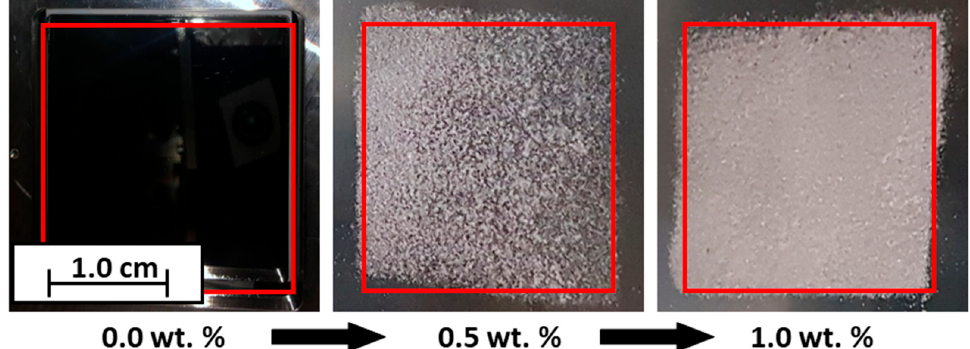
Figure 9. Example results of the electrophotographic powder deposition in a building chamber. From 0.0 wt.% CCS, no powder could be deposited photoelectrically; 0.5 wt.% Silica(+), electrophotographic